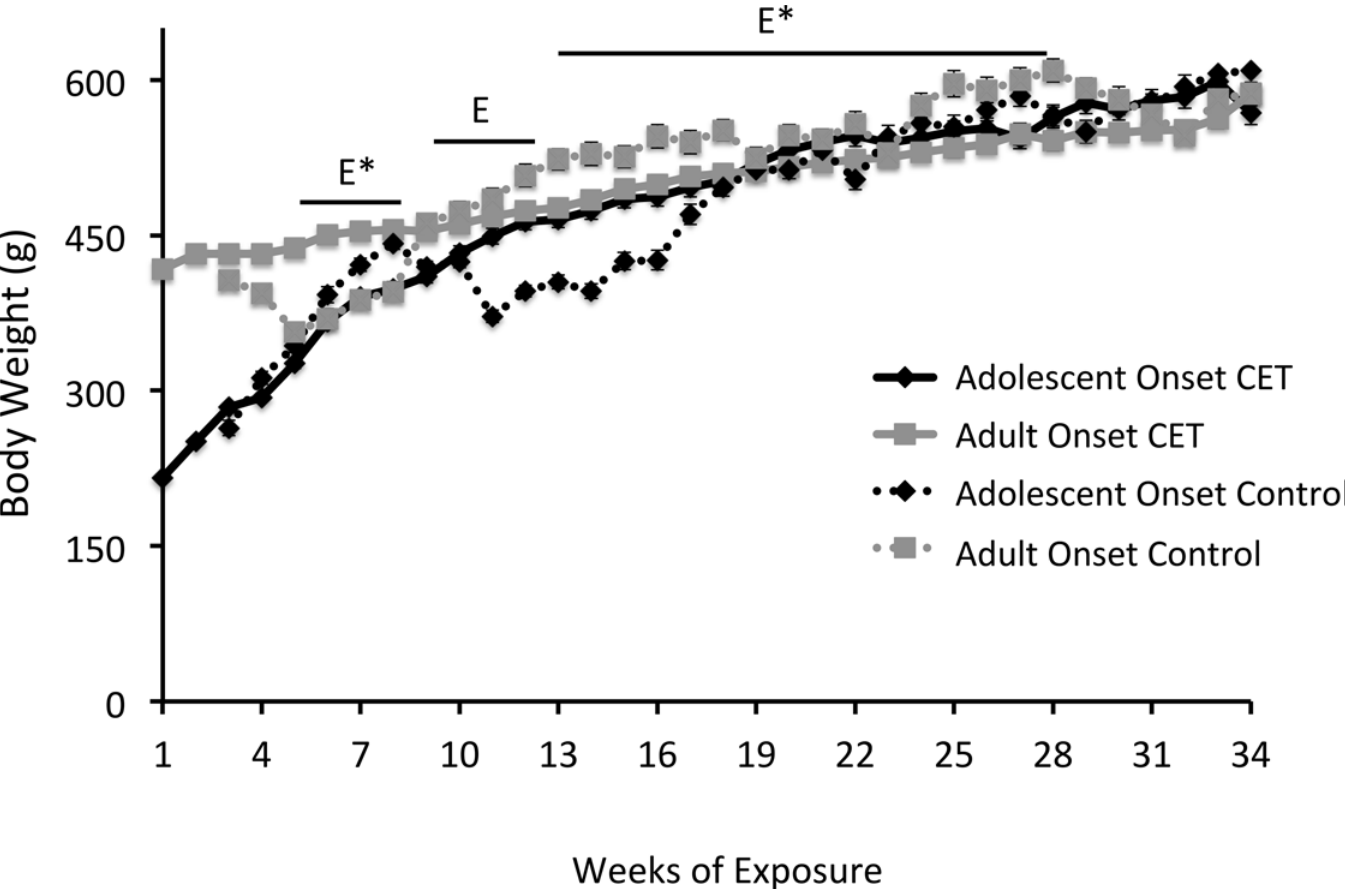
Fig 2. All rats gained weight across treatment, but there were time-points when group weight differences were evident. A significant difference was observed between adolescent onset CET and their age-matched controls during weeks 8 – 11 [E, p < 0.05], but not for the remainder of the experiment. During weeks 4 – 7 and 12 – 27 [E * , p < 0.05], a significant difference was also observed between adult onset CET and their age- matched